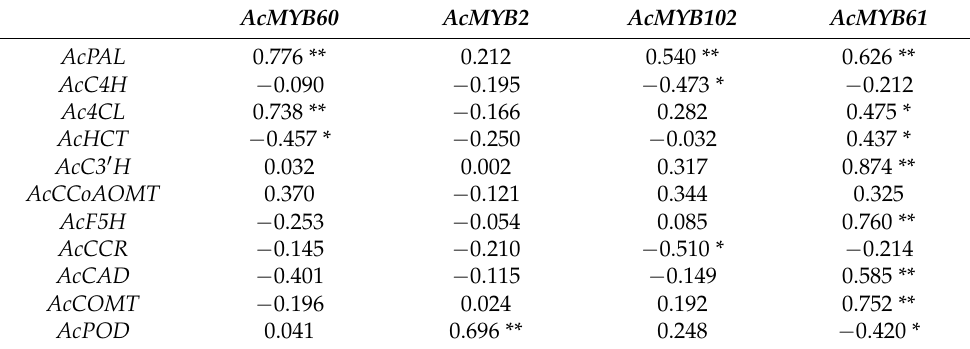
Table 2. Correlation between expression level of AcMYBs and lignin-biosynthesis-related genes in different tissues.